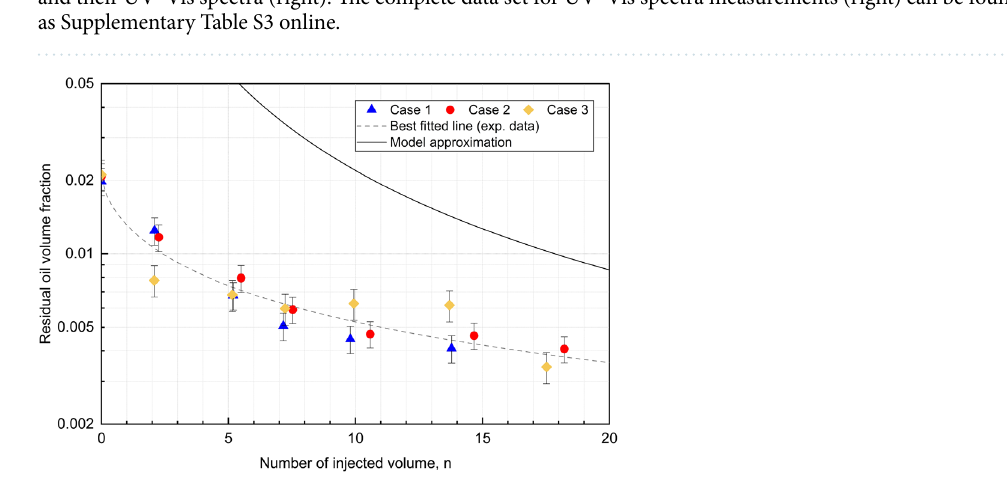
Figure 7. Measureded residual oil volume fraction as a function of injected pipe volumes, n . One pipe volume corresponds to approximately 0.18 L. The oil volume fraction and converted equivalent oil film thickness can be found as Supplementary Table S4 online. The model approximation curve, corresponding to an imposed flow rate of 1.05 L/min, is available as Supplementary Table S5